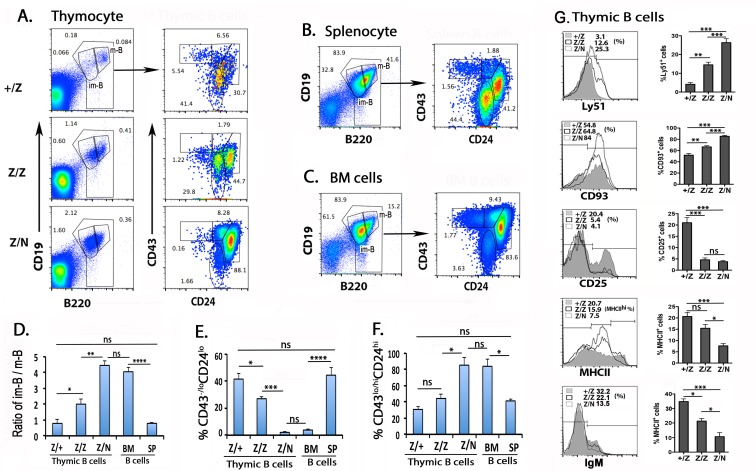
Most thymic B cells in the Foxn1lacZ thymus have an immature phenotype.(A). Representative profiles of CD19 and B220 staining (left panels) and CD24 and CD43 (right panels) on gated B cells in thymocytes from +/Z, Z/Z, and Z/N mice as indicated to the left. (B,C) Same analysis of splenocytes (B) and BM cells (C) from +/Z mice. (D). The ratio of CD19loB220lo immature B (im-B) to CD19hiB220hi mature B (m-B) cells in thymus, spleen and BM cells. (E-F). The percentage of CD43-/loCD24lo (E) and CD43lo/hiCD24hi (F) B subsets in total thymic B cells. (G). Histograms show overlapping profiles of Ly51, CD93, CD25, MHCII or IgM staining on gated thymic B cells from +/Z, Z/Z and Z/N mice. All assays were performed at day 30. Data are representative of five individual experiments, (+/Z: n = 7, Z/Z: n = 5, Z/N: n = 8). One-way ANOVA: *P <0.05, **P <0.01, ***P <0.001, ****P<0.0001. ns: not significant. Bars indicate means ± SEM.